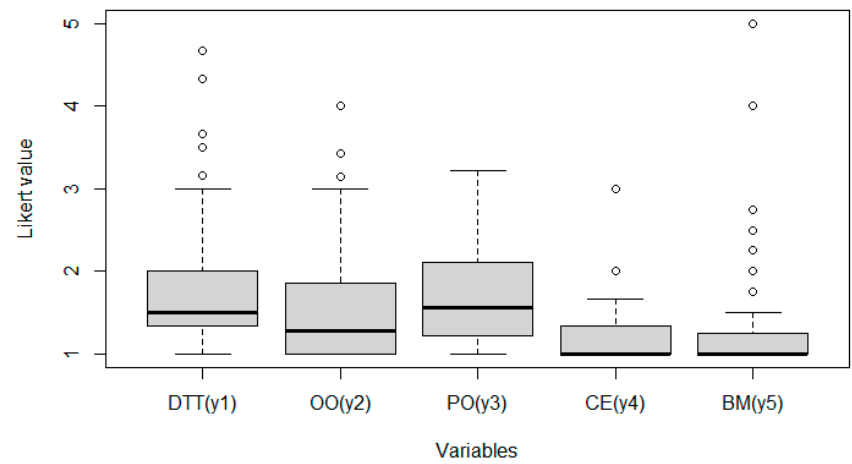
Figure 2. Boxplot of the output variables. Table 2. Correlation of input and output